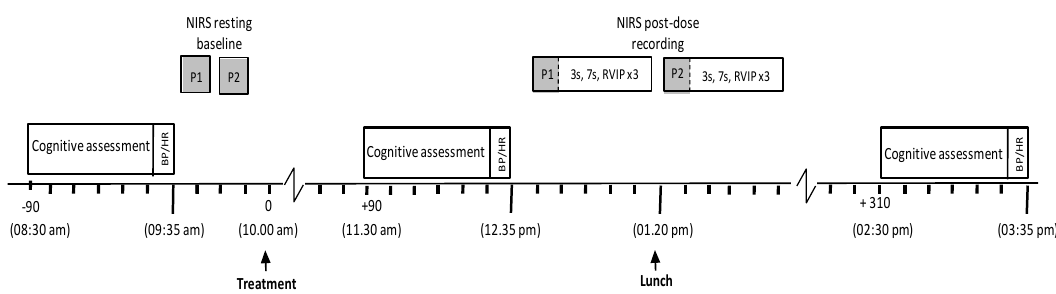
Figure 3. Testing session timeline for both active lab visits. Figure details the itinerary of the two acute lab visits with participants completing the pre-dose cognitive task battery (detailed in Figure 2), and blood pressure (BP) reading, at ~8:30 a.m. Each day, two participants could then be scheduled to provide pre-dose cerebral blood flow (CBF) readings before all participants consumed treatment at ~10:00 a.m. Ninety minutes later, the first post-dose cognitive task battery, and BP, was completed, after which the aforementioned sub-sample of participants provided post-dose CBF data (5 min rest followed by three completions of the 10 min cognitive demand battery) before/after lunch. At 310 min post-dose, all participants then completed the second post-dose task battery and BP and the day was completed.